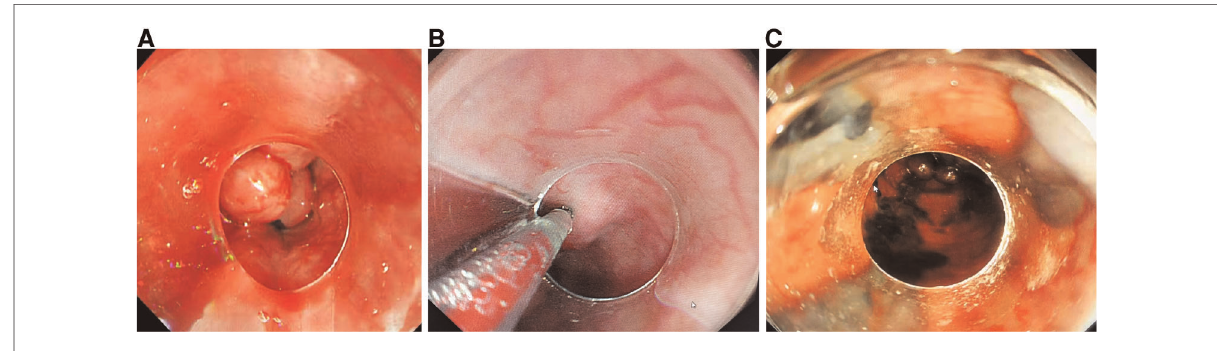
FIGURE 1 ( A ) Esophageal variceal ligation, ( B ) sclerosant injecting into each varicose vein, and ( C ) sclerosant in the varicose